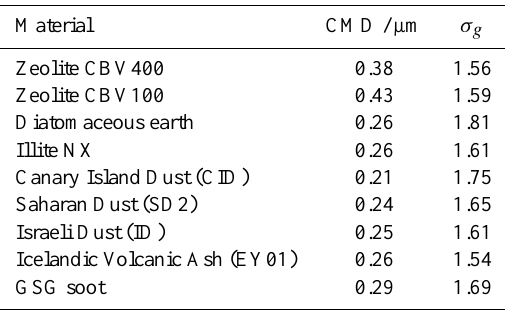
Table 1. Log-normal fit parameters for the number size distributions of the investigated aerosol particles.